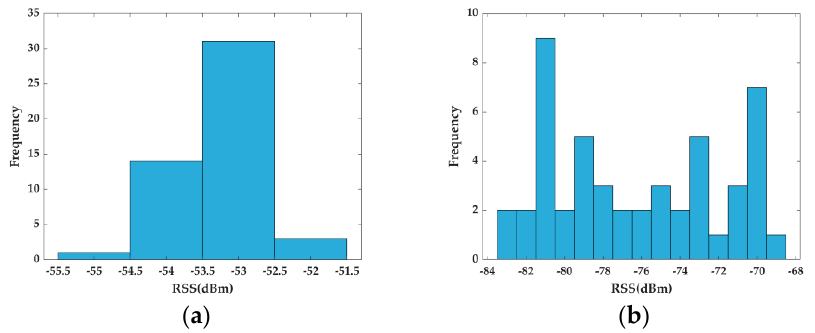
Figure 2. Histograms of 50 RSS samples collected at two different RPs: ( a ) RSS measurements are clustered and span a small range and it is reasonable to characterize this RP by RSS mean value; ( b ) RSS measurements spread a wider range and appear to have multiple model distribution and it is not reliable to characterize this RP by RSS mean value.